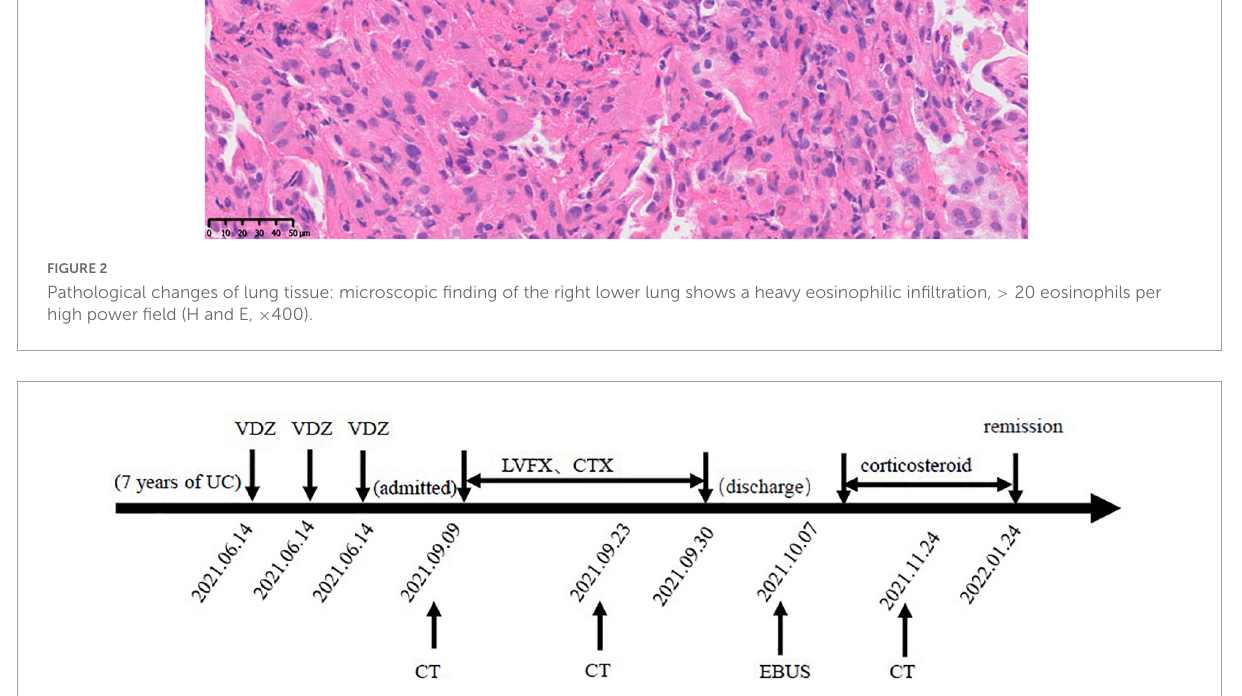
FIGURE3 Changes in the condition after vedolizumab (VDZ) therapy. VDZ, vedolizumab; LVEF, levofloxacin; CTX, cefotaxime; CT, computed tomography; EBUS, endobronchial